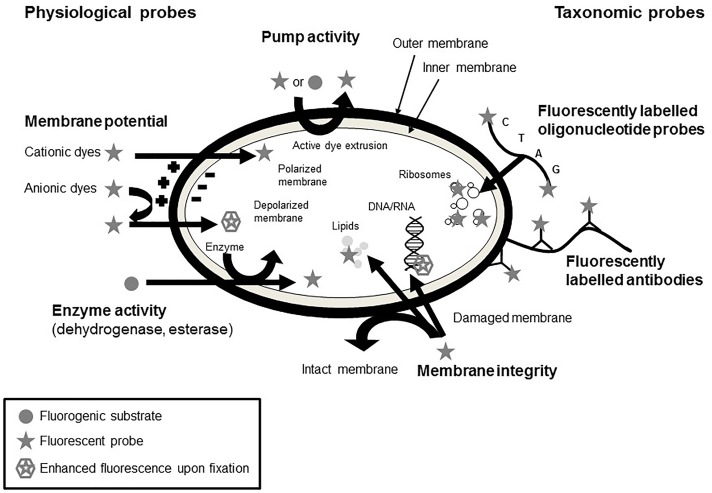
Mechanisms of action of different staining procedures for the evaluation of physiological fitness of microorganisms (adapted from Joux and Lebaron, 2000; Ben Amor, 2004).